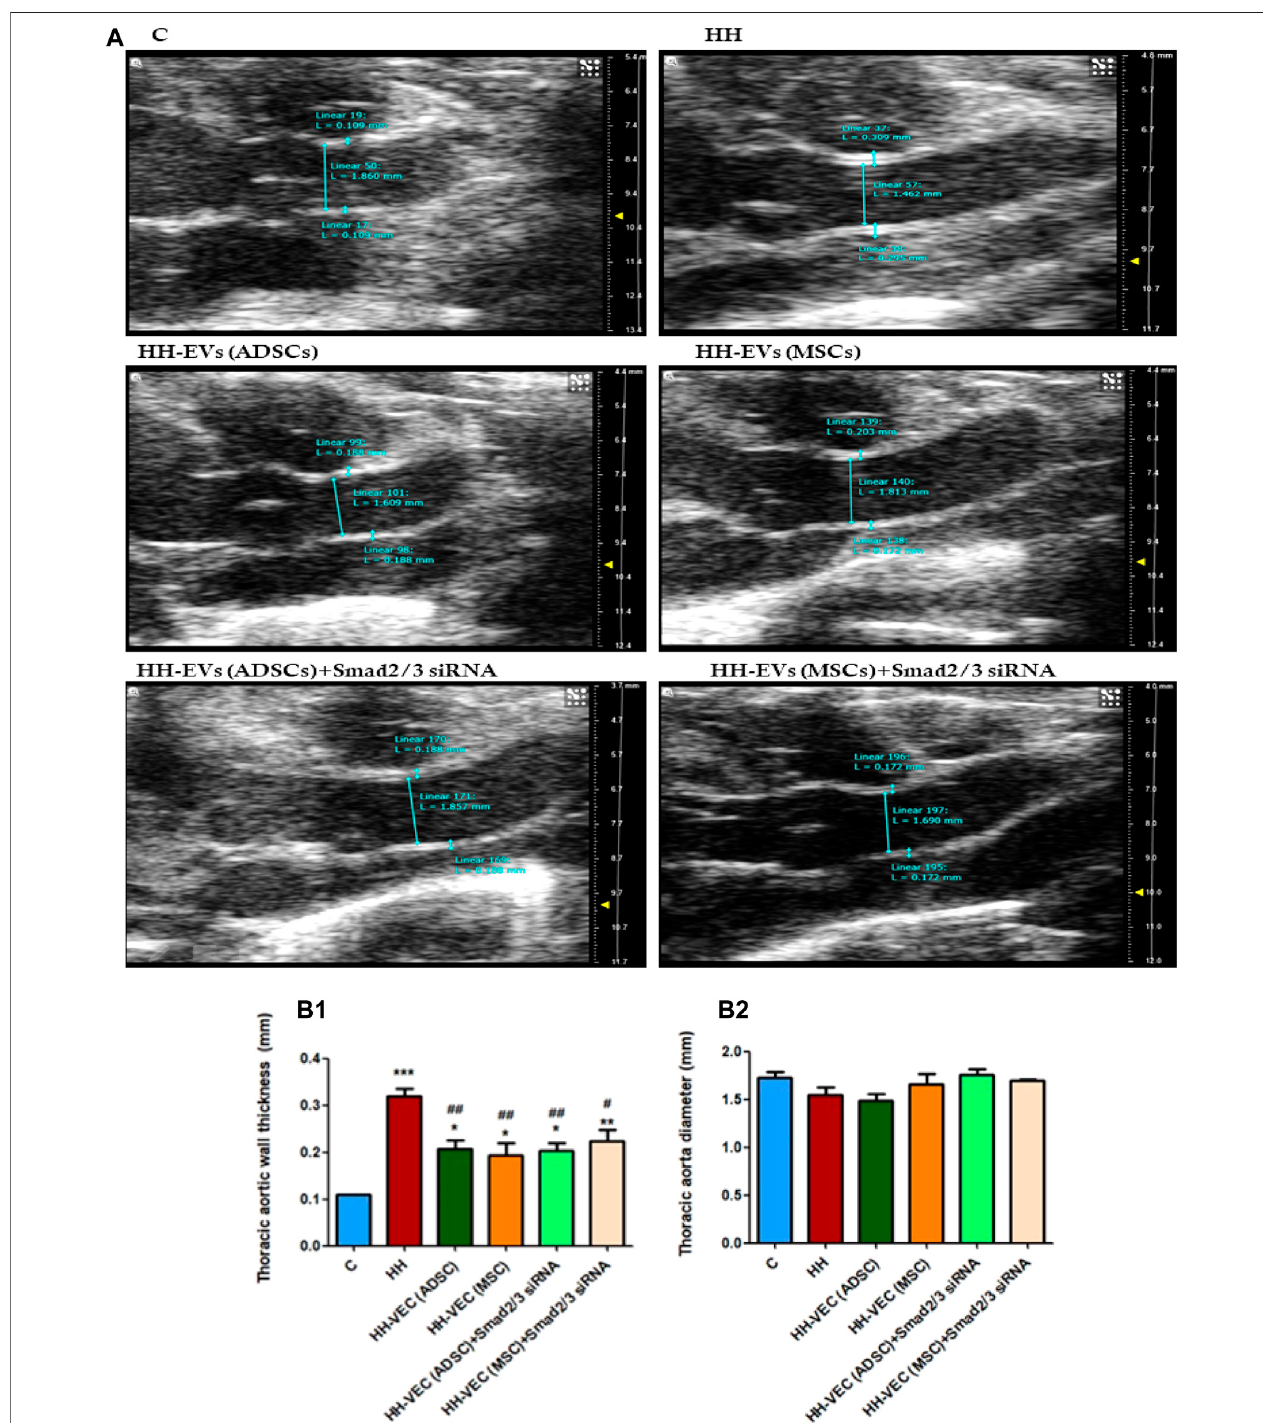
FIGURE5| Changesintheblood fl owandstructureofthethoracicaortaandcarotidarterywereisolatedfromtheinvestigatedexperimentalgroups(C,HH,HH-EVs(ADSCs), HH-EVs(MSCs),HH-EVs(ADSCs)+Smad2/3siRNA,and HH-EVs(MSCs)+Smad2/3siRNA)asameasureofvascularrigidity. (A) RepresentativeB-moderecordings,which highlight thewallthicknessandtheinnerdiameterofthethoracicaorta; (B) graphicalrepresentationofwallthickness(mm) (B.1) andinnerdiameter(mm) (B.2) inthecaseofthethoracicaorta; (C) representative records obtained in M-mode, which highlight the diameter in systole and diastole of the thoracic aorta; (D) graphical representation of thoracic aortic distensibility(mm); (E) representativerecordingsobtainedinpulsedDoppler-mode,whichhighlightthevelocitytimeintegral(VTI)andvelocity (Vel)ofthethoracicaorta; (F) graphical representationofvelocity(mm/s) (F.1) andvelocitytimeintegral(mm) (F.2) atthelevelofthethoracicaorta; (G) representativeB-moderecordings,whichhighlightthewallthickness andtheinnerdiameterofthecarotidartery; (H) graphicalrepresentationofwallthickness(mm) (H.1) andinnerdiameter(mm) (H.2) inthecaseofthecarotidartery.Dataareshownas themean±SDofeachexperimentalgroupafter4 monthsofdietandtreatment.Thestatisticalsigni fi cance,noticeablydifferent,isrepresentedas*** p < 0.005,** p < 0.01,* p < 0.05 versus control group and ### p < 0.005, ## p < 0.01, # p < 0.05 versus HH group. The values were calculated by two-way ANOVA and Bonferroni post-test.